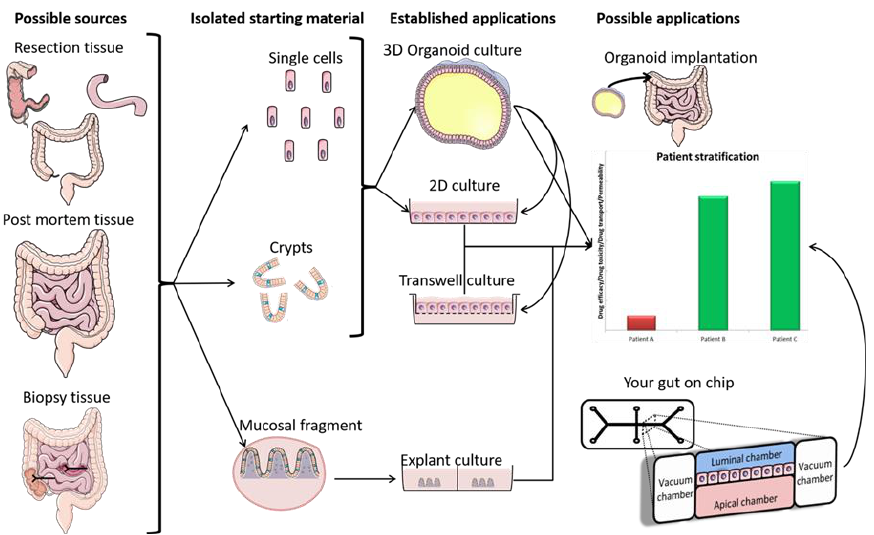
Figure 4. A representation of the generation of 2D and 3D organoids, and their application. Resection-, post mortem-, and biopsy tissue can be used to acquire crypts or single stem cells, which can then be cultured as organoids following de- scribed protocols. The 3D Organoids can be exposed to microbes and drugs by microinjection, while the transwell culture (2D) allows both luminal and basolateral exposure. The possible applications are discussed in the text and depicted in the right panel. Adapted with permission from [198], SAGE Publications,